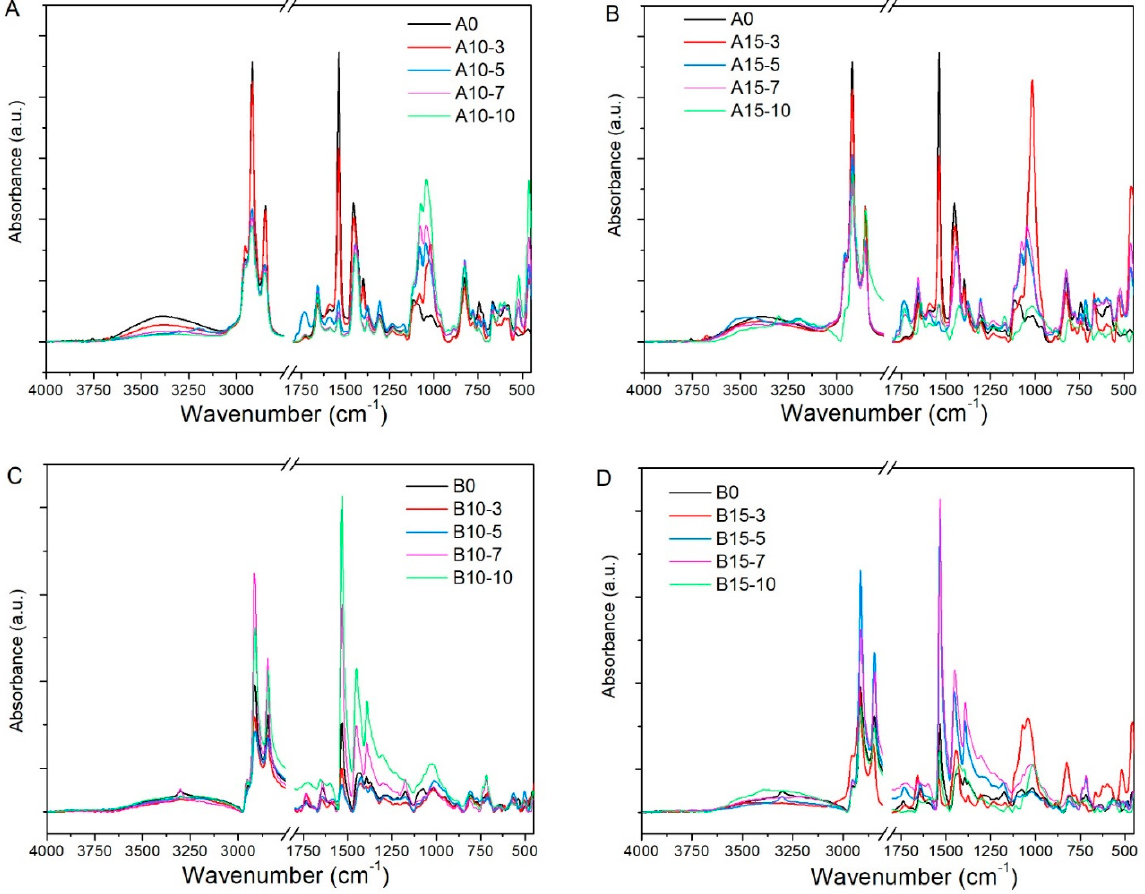
Figure 3. FT-IR spectra of rubber nanocomposites containing different types and amounts of fillers. ( A ) Cloisite ® 10A. ( B ) Cloisite ® 15. ( C , D ) Cloisite ® 10A and Cloisite ® 15 plus carbon black N330, respectively.